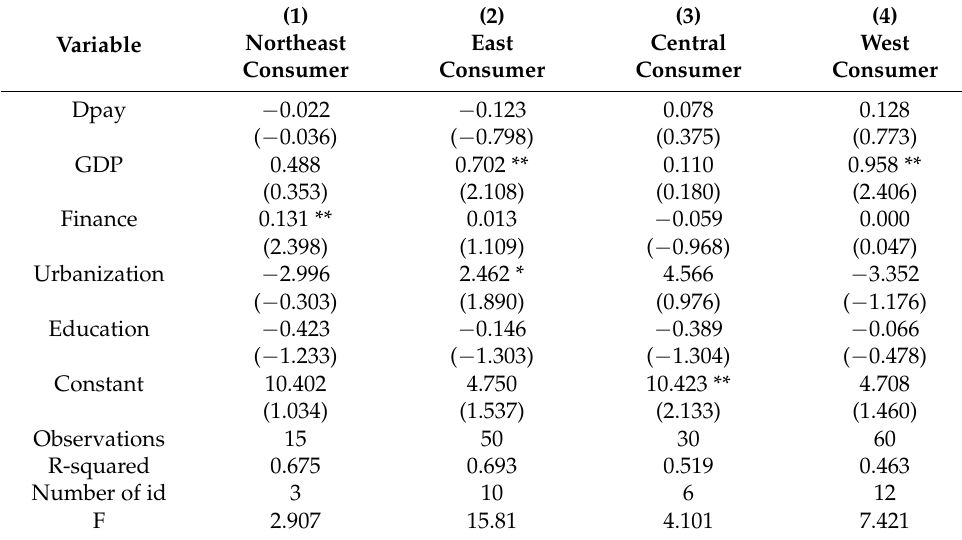
Table 14. Time heterogeneity test: 2016–2020.